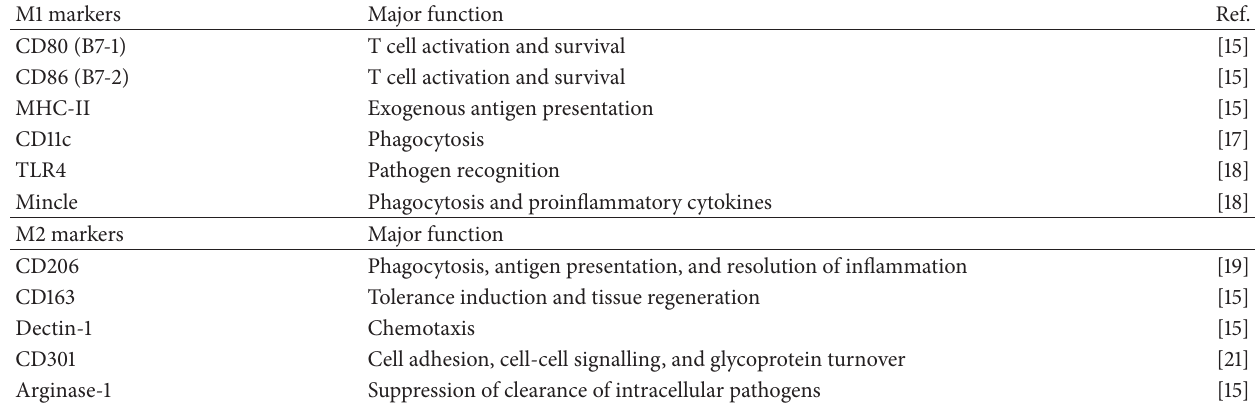
Table 1: Typical surface markers and functions in M1 and M2